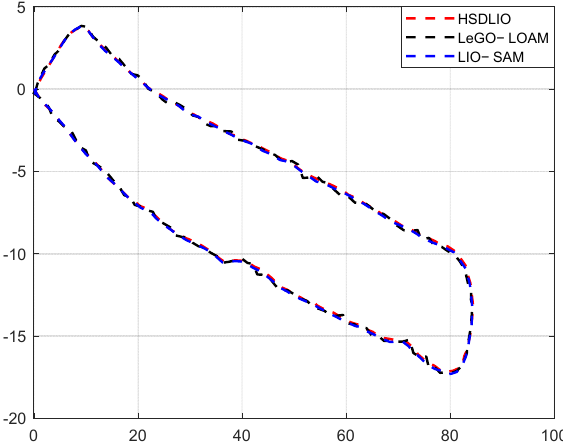
Figure 14. Comparison of LeGO-LOAM, LIO-SAM, and HSDLIO trajectories. The red dashed line is the trajectory of HSDLIO, the blue dashed line is the trajectory of LIO-SAM, and the black dashed line is the trajectory of LeGO-LOAM. Table 3. Relative translational error when the backpack returns to the starting point (meters).